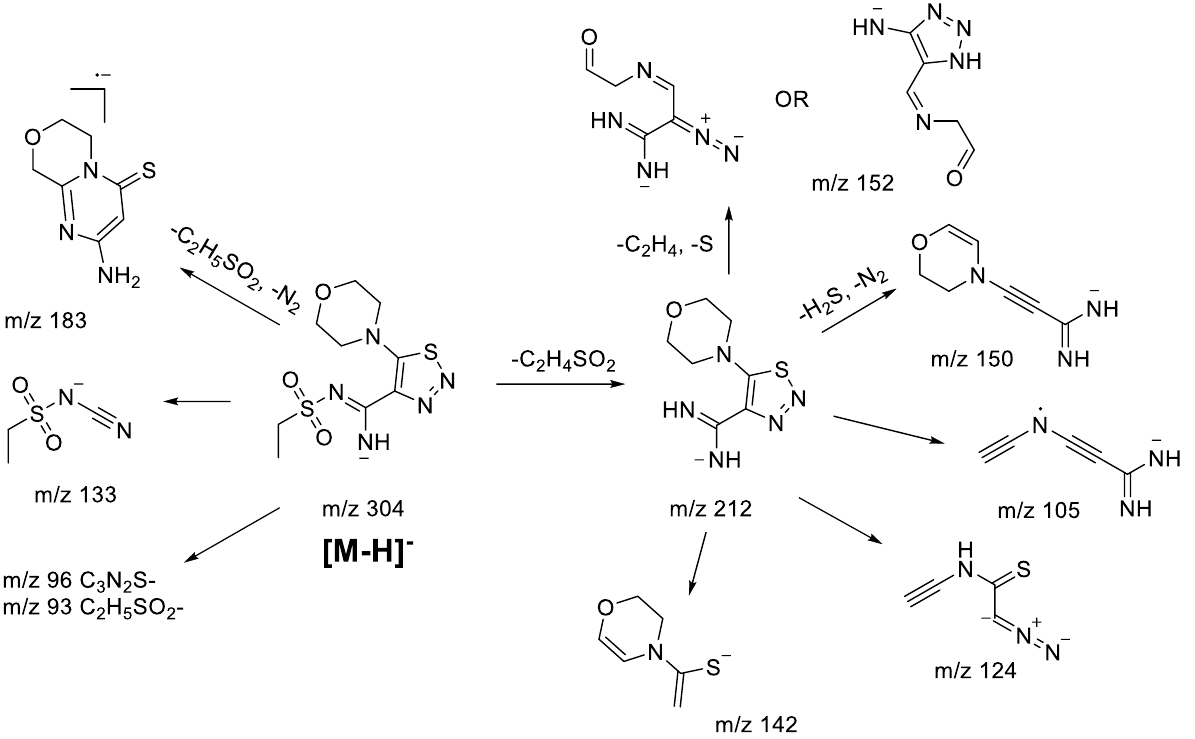
Scheme 8. Fragmentation pathways of deprotonated 1,2,3-thiadiazole 1gS including the most char- acteristic ions formed under (−)ESI -MS/MS